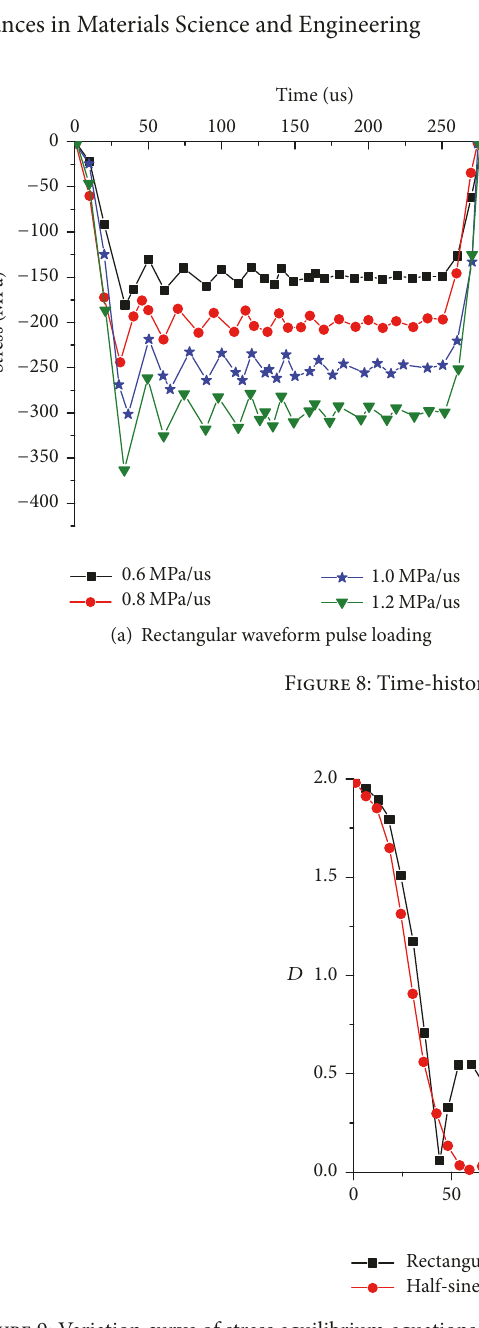
waveform loadings are chosen. The wave dispersion and the stress uniformity process under two input wave loadings are analyzed by conducting large-diameter SHPB